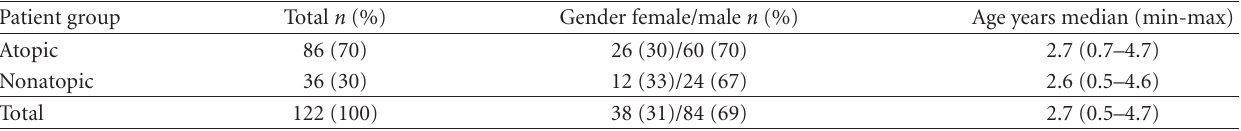
Table 1: Distribution of patients by atopic classification, gender and age.